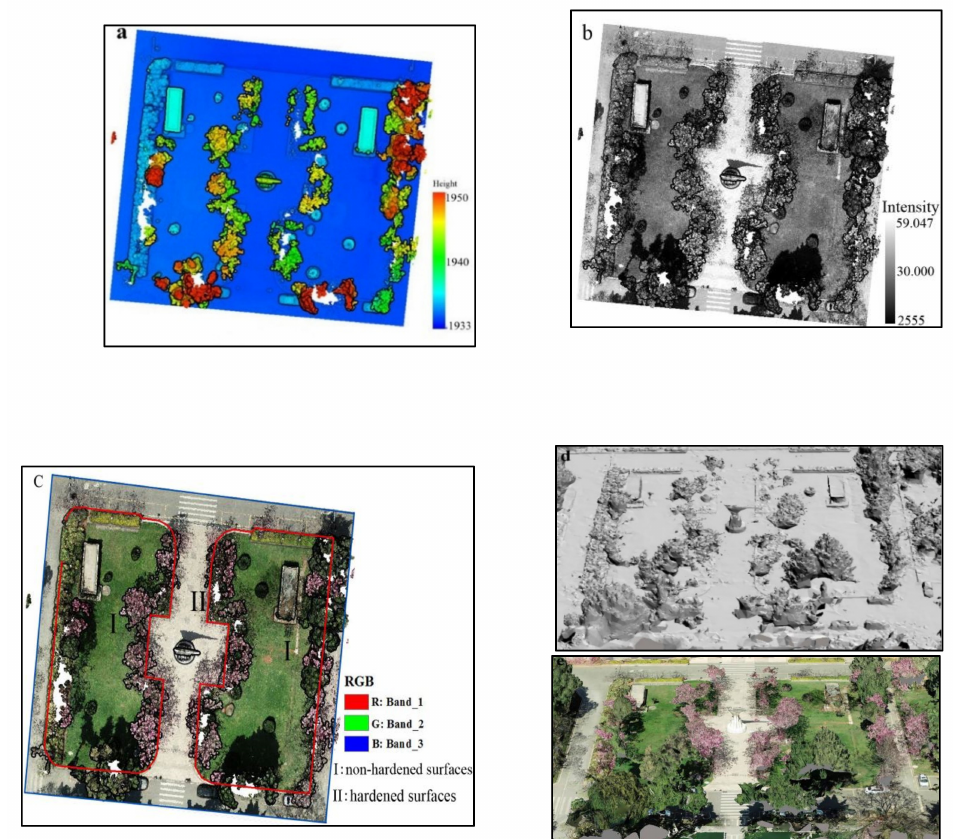
Figure 3. Visual analysis ( a ) DSM+ elevation rendering; ( b ) DSM+ intensity rendering; ( c ) DSM+ texture mapping + Plot outline; ( d ) 3D white mold; ( e ) 3D